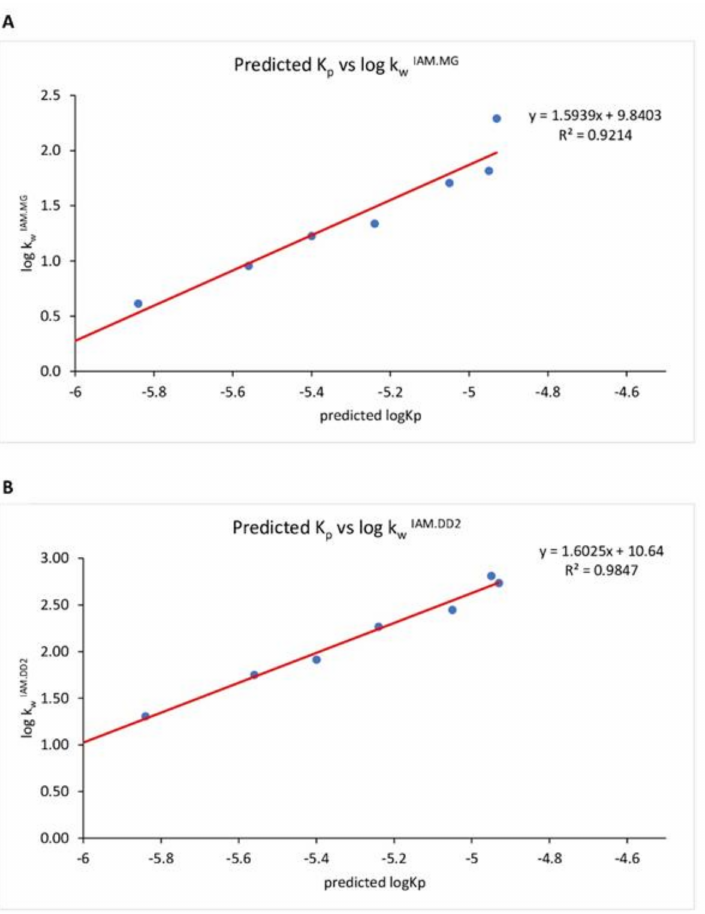
Figure 3. Relationship between Log Kp values achieved from SwissADME ® software and log kw IAM.MG ( A ) and logkw IAM.DD2 ( B ) values achieved by IAM chromatography. A good relationship is observed, demonstrating that IAM experimental data of affinity for phospholipid agree with skin permeation